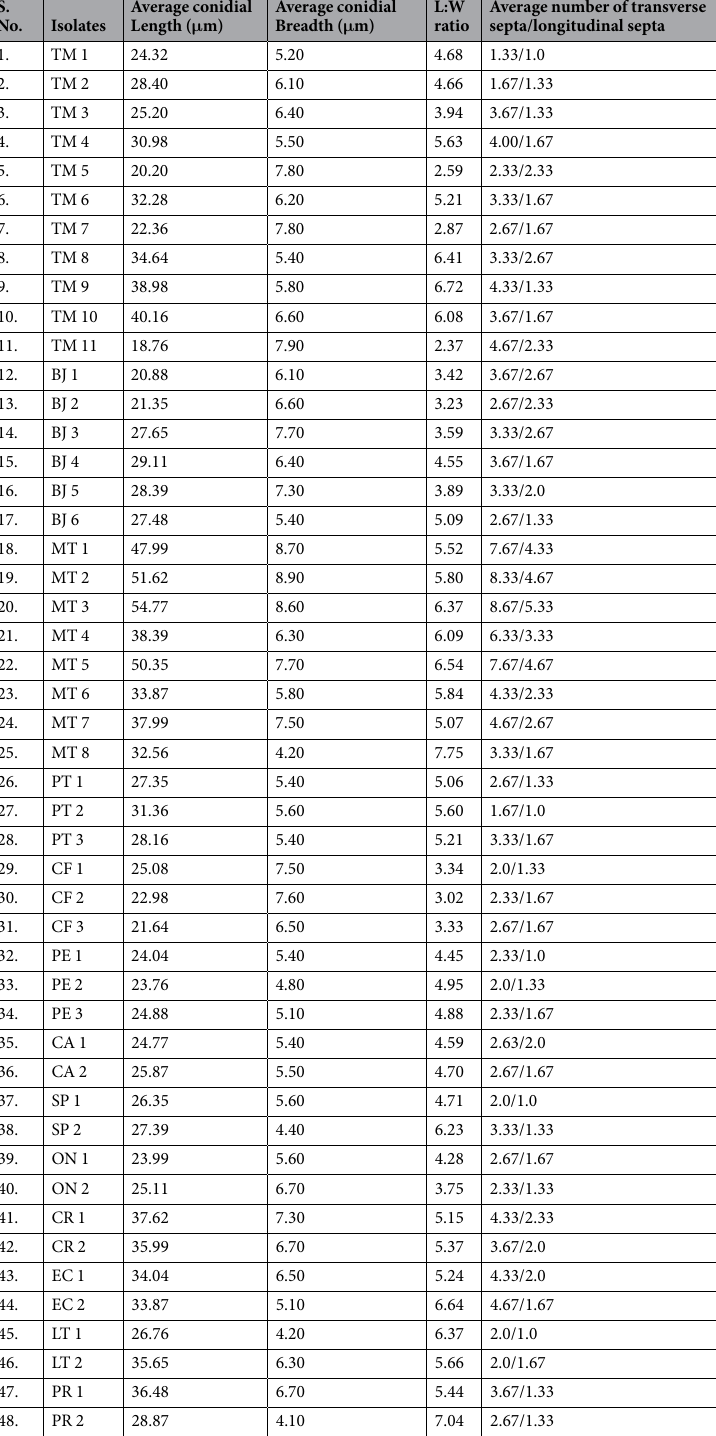
Table 2. Measurement of different morphological structures of isolated Alternaria species. Note: The size and shape of conidia length and width (L:W) was determined using ocular and stage micrometer. Numbers of septa (transverse/longitudinal septa) were also